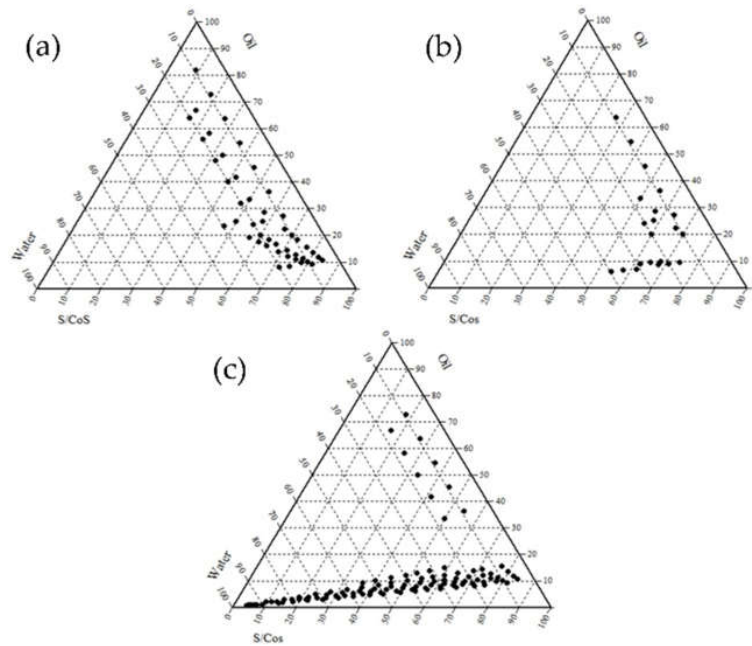
Figure 2. Pseudo-ternary phase diagram of microemulsion composed of oil (IPM), surfactant (Labrasol, Tween 80 and Cremophor EL ® )-co-surfactant (PG) mixture (1:1 ratio, w / w ) and water ( a ) oil (IPM), S/CoS (Labrasol:PG, 1:1); ( b ) oil (IPM), S/CoS (Tween 80:PG, 1:1); ( c ) oil (IPM), S/CoS (Cremophor EL ® : PG, 1:1).